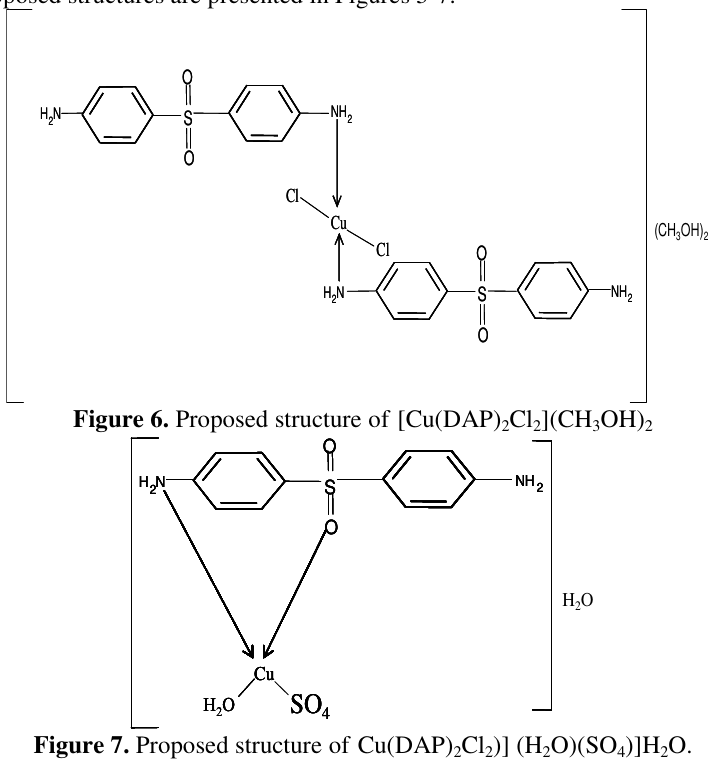
Cl )] (H O)(SO 2 2 2